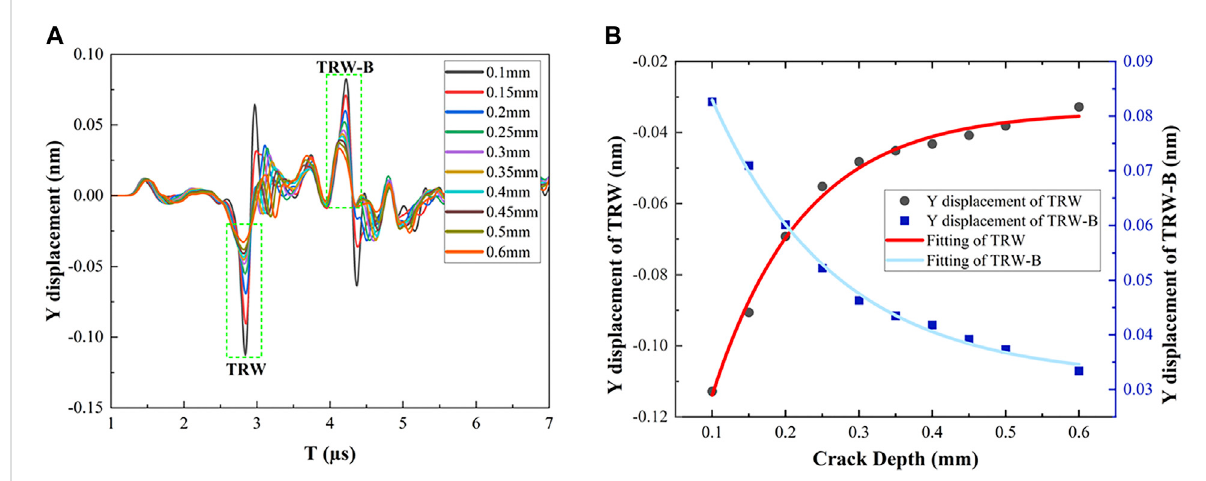
FIGURE 10 Y displacement and Fitting curves: (A) Different depths on the opposite side; (B) Fitting curves for TRW (red) and TRW-B